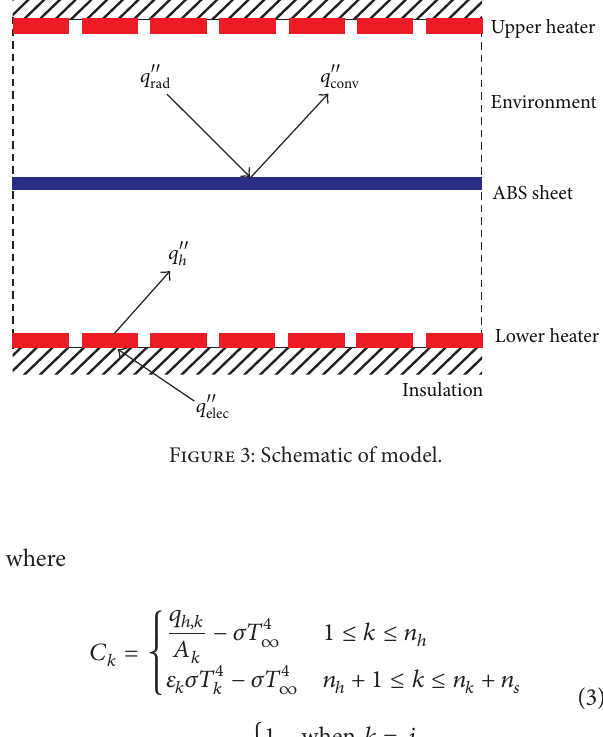
Figure 3: Schematic of